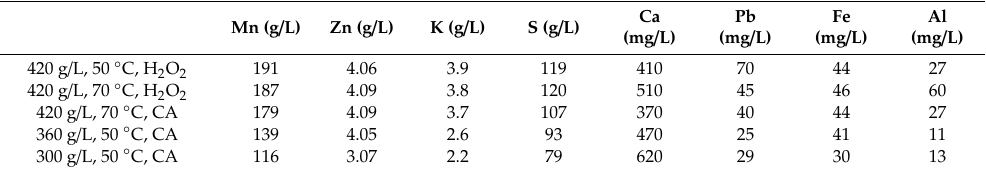
Table 3. Elemental analysis of the purity of leachates after reductive leaching.